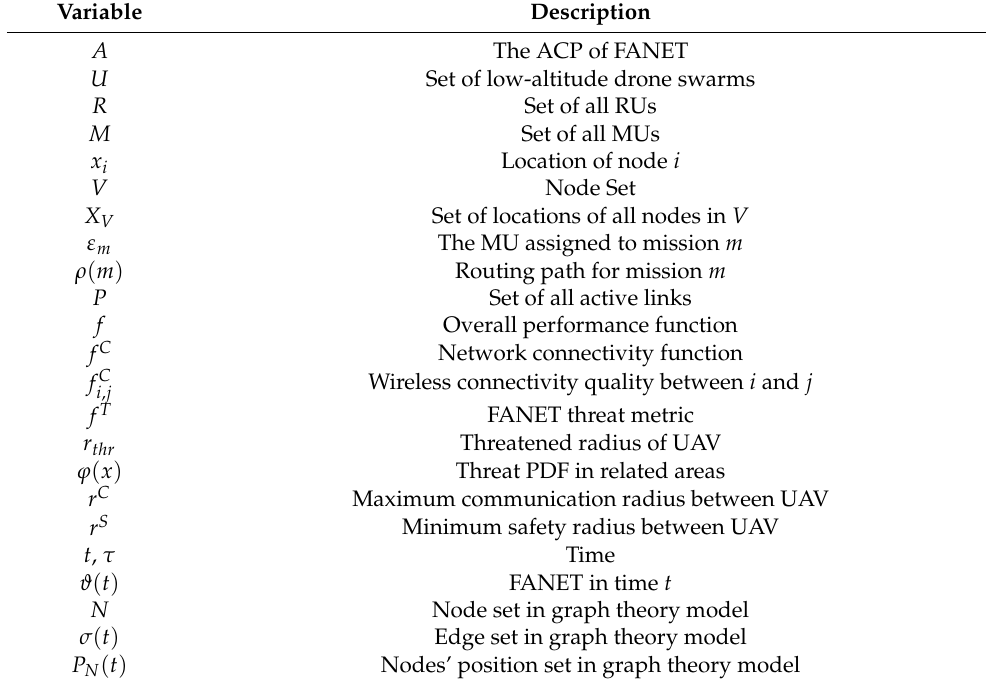
Table 2. List of